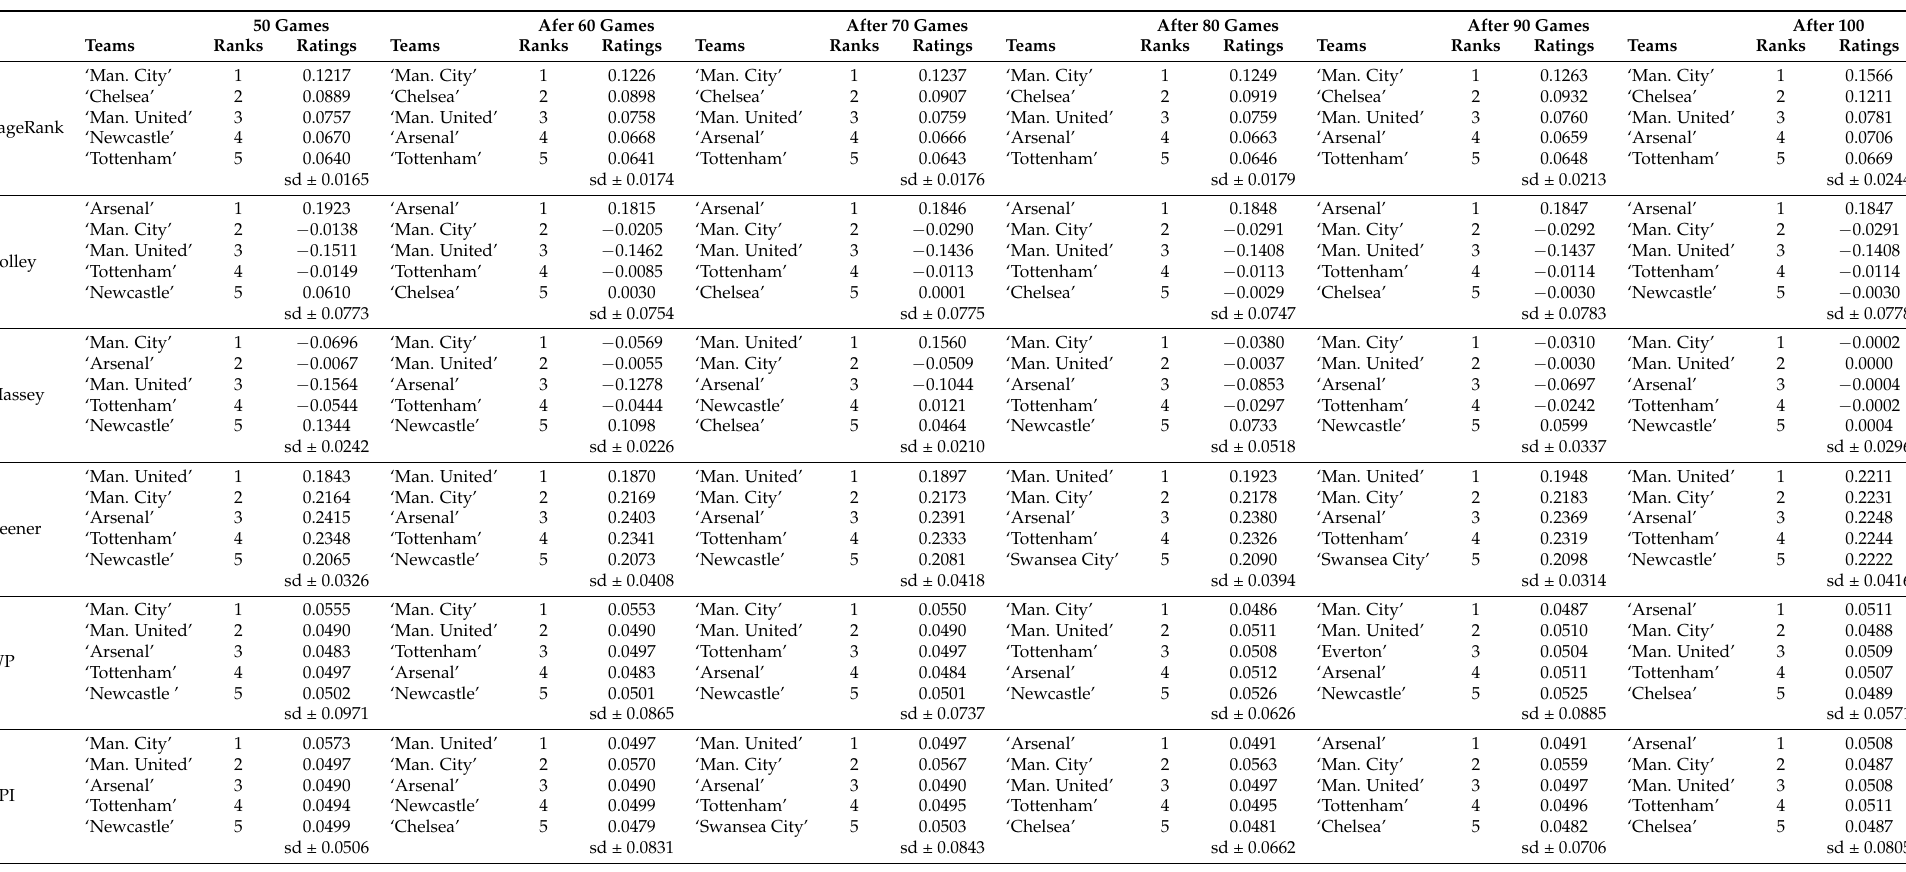
Table A2. Detailed comparison of top-5 teams rate–rank by expanding window